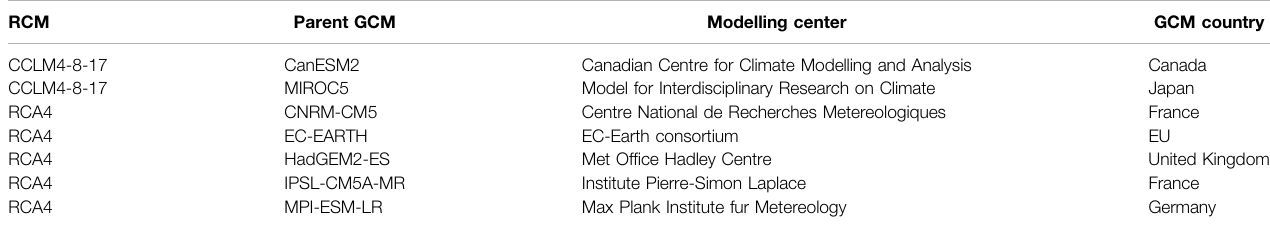
TABLE 2 | List of the analyzed RCM simulations and their downscaled GCMs from CMIP5.